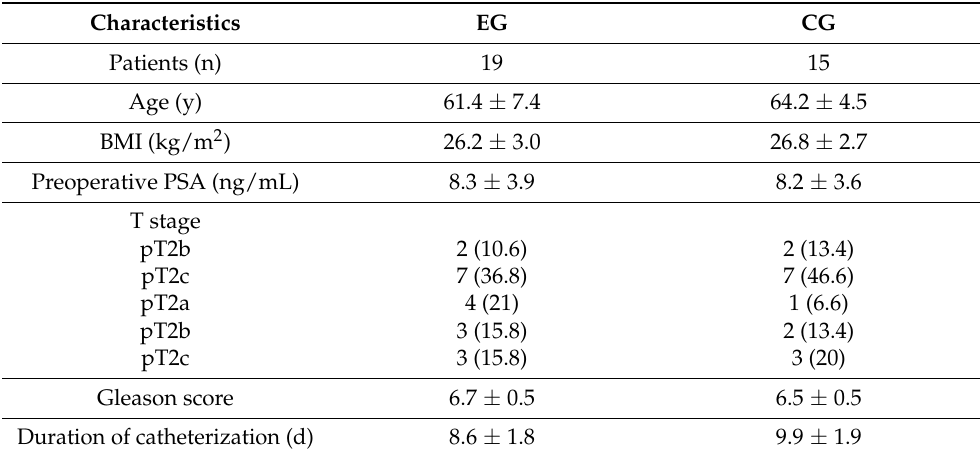
Table 1. Study population